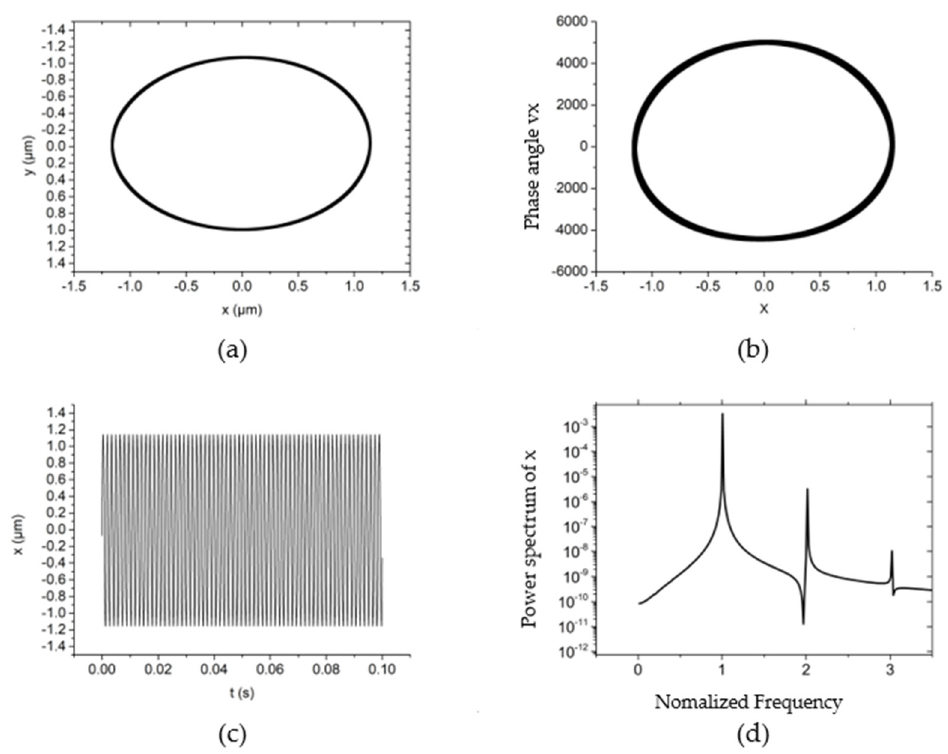
Figure 3. The non-linear dynamic behavior of the rotor at w = 30,000 r/min, Fy = 10 N, m u = 0.01 g, Figure 3. The non ‐ linear dynamic behavior of the rotor at w = 30,000 r/min, Fy = 10 N, m u m = 30 g. ( a ) rotor center trajectory, ( b ) phase angle in x -direction, ( c ) x displacement time-domain = 0.01 g, m = 30 g. ( a ) rotor center trajectory, ( b ) phase angle in x ‐ direction, ( c ) x displace ‐ curve, ( d ) power spectral density in the x ment time ‐ domain curve, ( d ) power spectral density in the x ‐ direction.